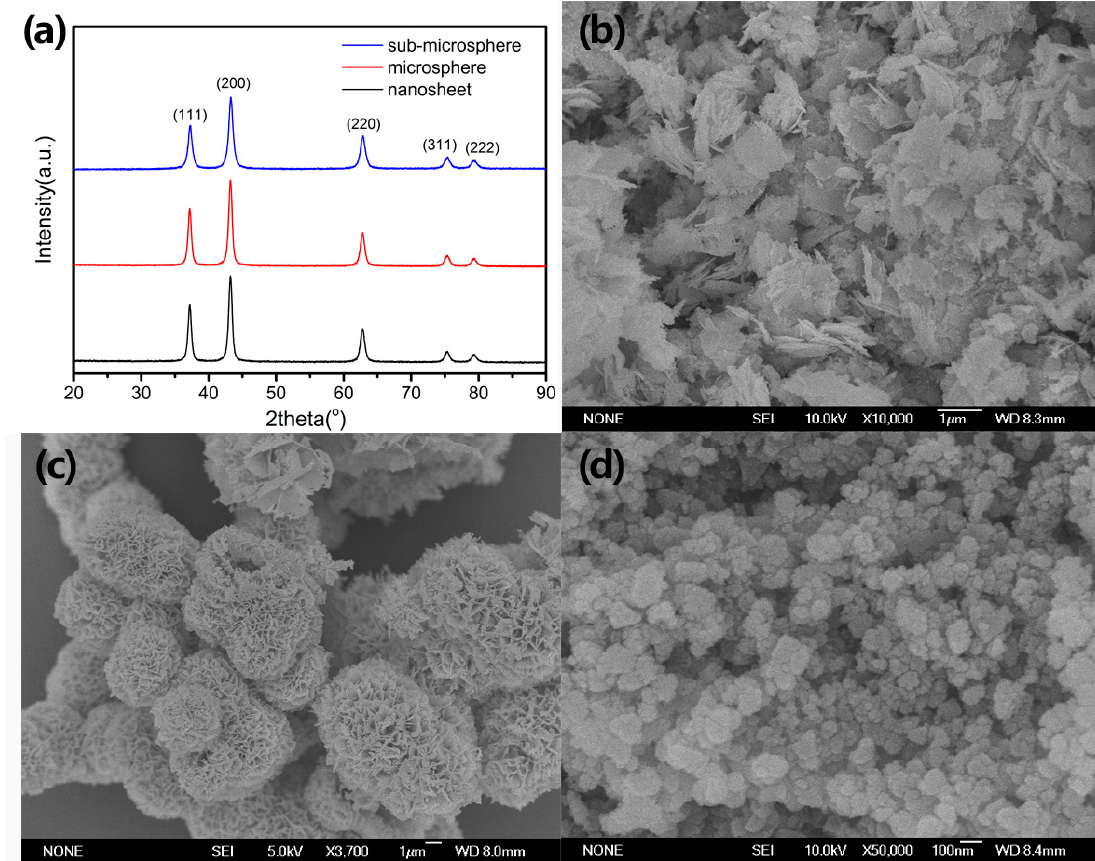
Figure 2. ( a ) XRD (Cu K α , λ = 0.15406 nm) patterns and SEM images (secondary electron imaging mode) of as-prepared ( b ) nickel oxide (NiO) nanosheet; ( c ) NiO microsphere; and ( d ) NiO sub- microsphere.